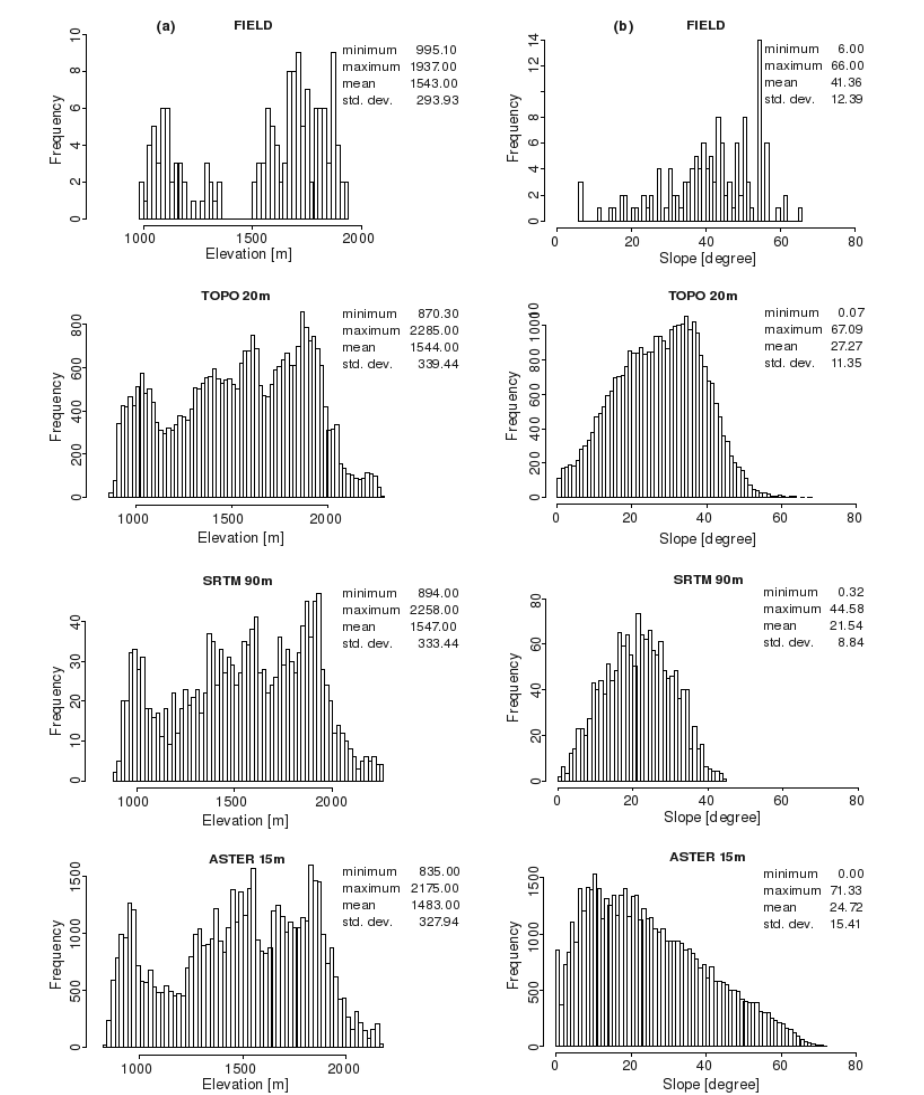
Figure 3. Frequency histograms and univariate statistics showing (a) field measured elevations and DEM derived elevations at original resolutions, and (b) field measured slopes and DEM derived slopes at original